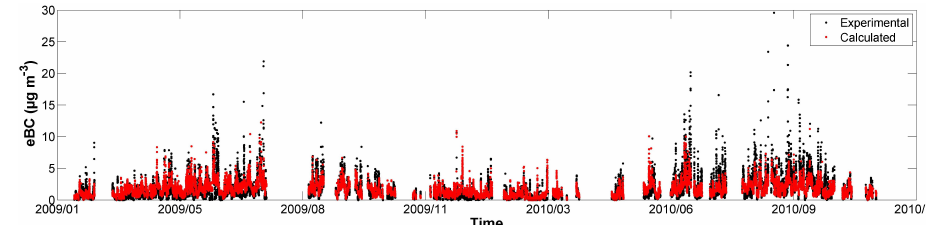
Figure 17. Actual eBC compared with calculated eBC (using Eq. 2) for the entire monitoring period at Elandsfontein.